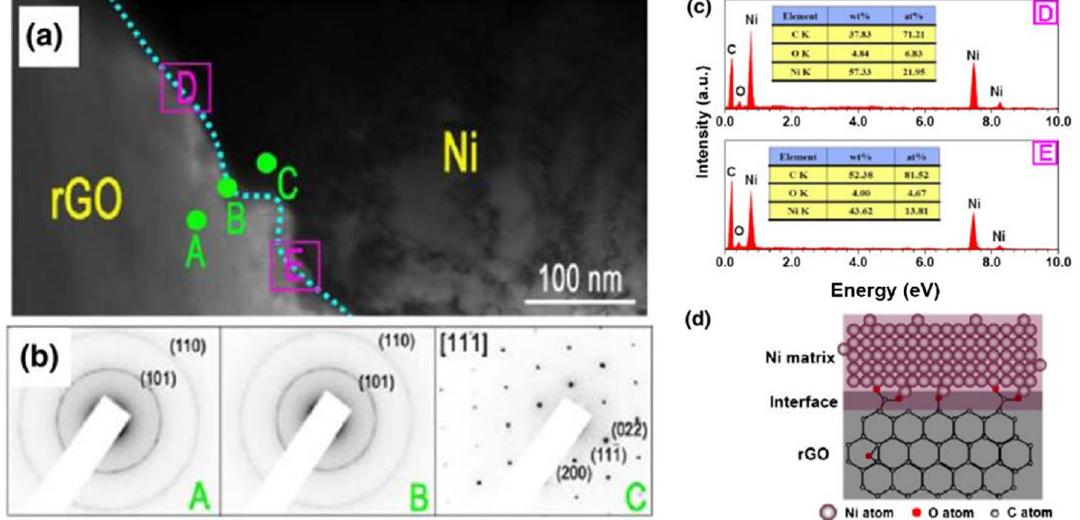
Fig. 13 (a) Transmission electron microscopy (TEM) image of the interface between rGO and Ni matrix. (b) Selected area electron diffraction patterns and (c) electron energy-dispersive X-ray spectrometry results at the regions marked in (a). (d) Schematic of interface bonding. Reproduced with permission from Ref. [91], © Springer Nature